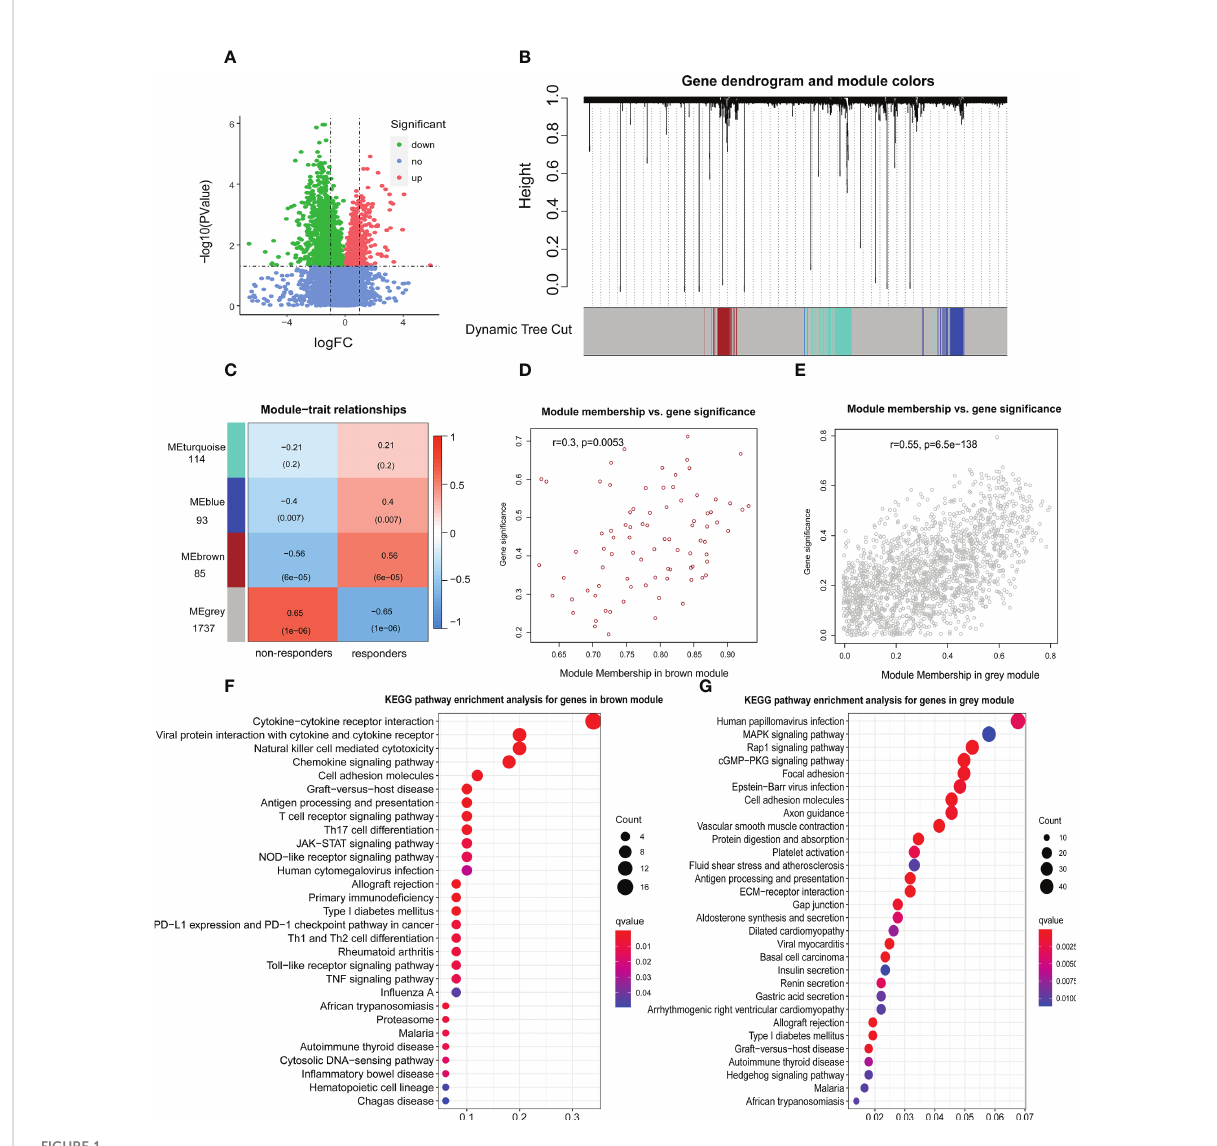
FIGURE 1 Identi fi cation of genes associated with immunotherapy response. (A) The volcano fi gure of differentially expressed genes (DEGs) associated with immunotherapy response in the Kim cohort. logFC: log-fold changes. (B) Weighted gene coexpression network analysis (WGCNA) of 2759 DEGs with a soft threshold b = 26. (C) Heat maps showing the gene modules associated with immunotherapy response. The relationship between the gene signature and brown module genes (D) or grey module genes (E) . Kyoto Encyclopedia of Genes and Genomes (KEGG) pathway enrichment analysis for genes in brown module (F) or grey module (G)